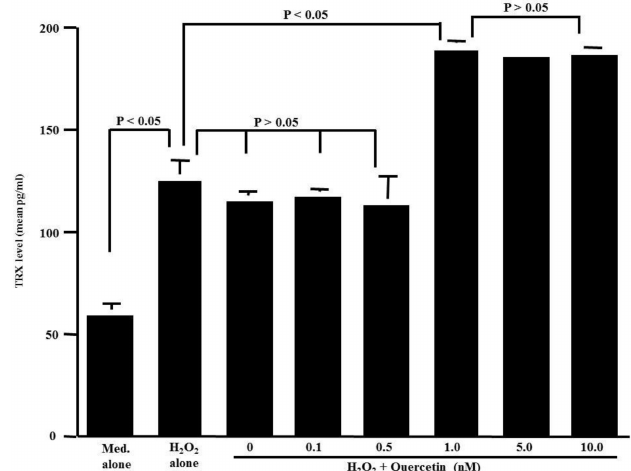
Figure 2. Influence of quercetin on thioredoxin (TRX) production from HNEpCs induced by H 2 O 2 stimulation in vitro. Nasal epithelial cells (5 × 10 5 cells) were stimulated with 50 µ M H 2 O 2 in the presence of various concentrations of quercetin for 24 h. TRX levels in culture supernatants were examined with ELISA. The data are expressed as the mean pg/mL ± SE of triplicate cultures. One representative experiment of two is shown in this figure. Med. alone: Medium